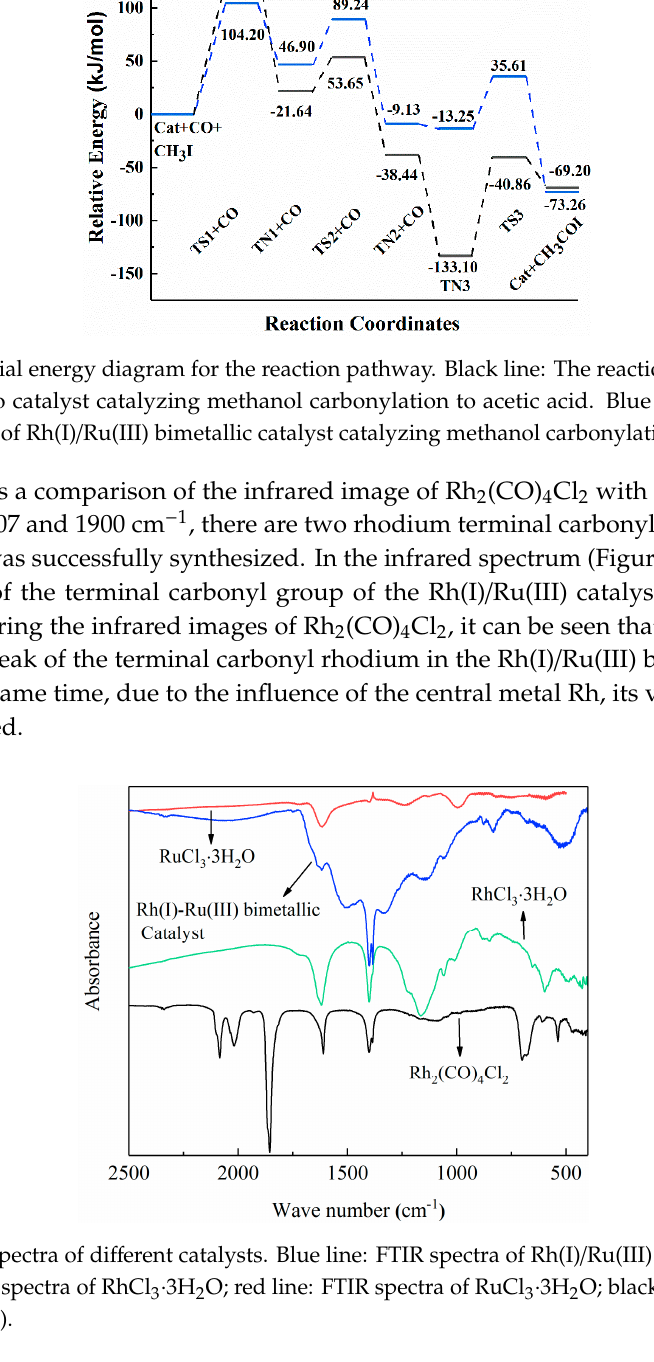
Figure 4. Geometric structure of reactants, transition states, intermediates, and products in methanol